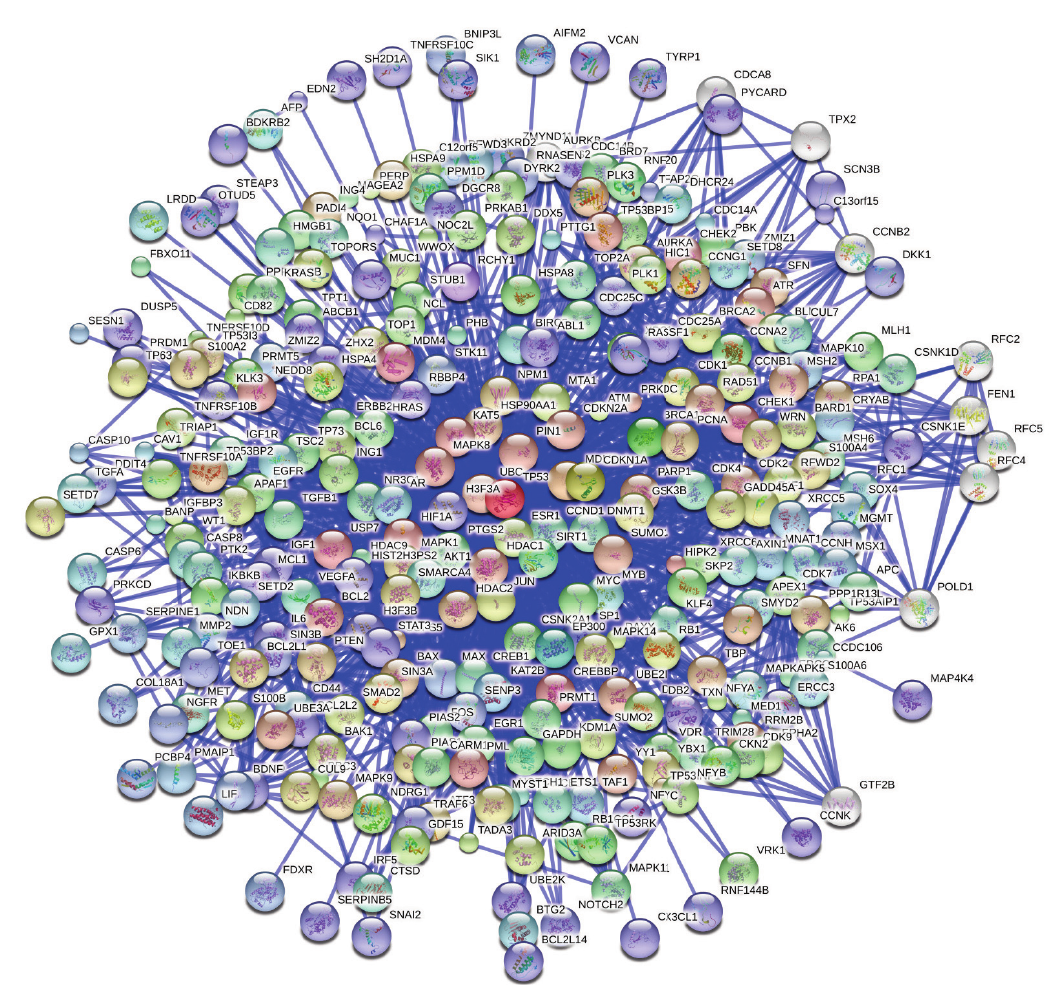
Figure 9. STRING-based extended interactome of p53. This network was built by setting the number of interactors to 500 and the STRING confidence level of 0.900. Therefore, this network includes only partners whose interactions are predicted with the highest confidence level